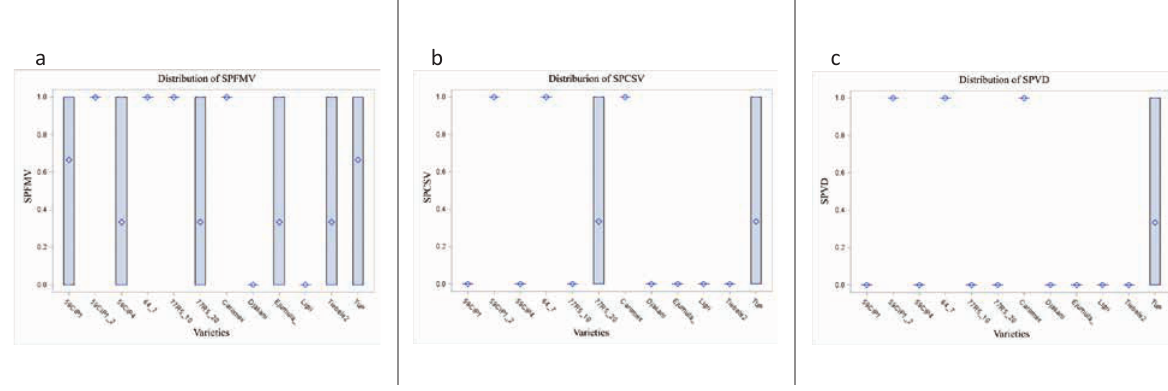
Figure 3: SPFMV, SPCSV and SPVD distribution according to varieties